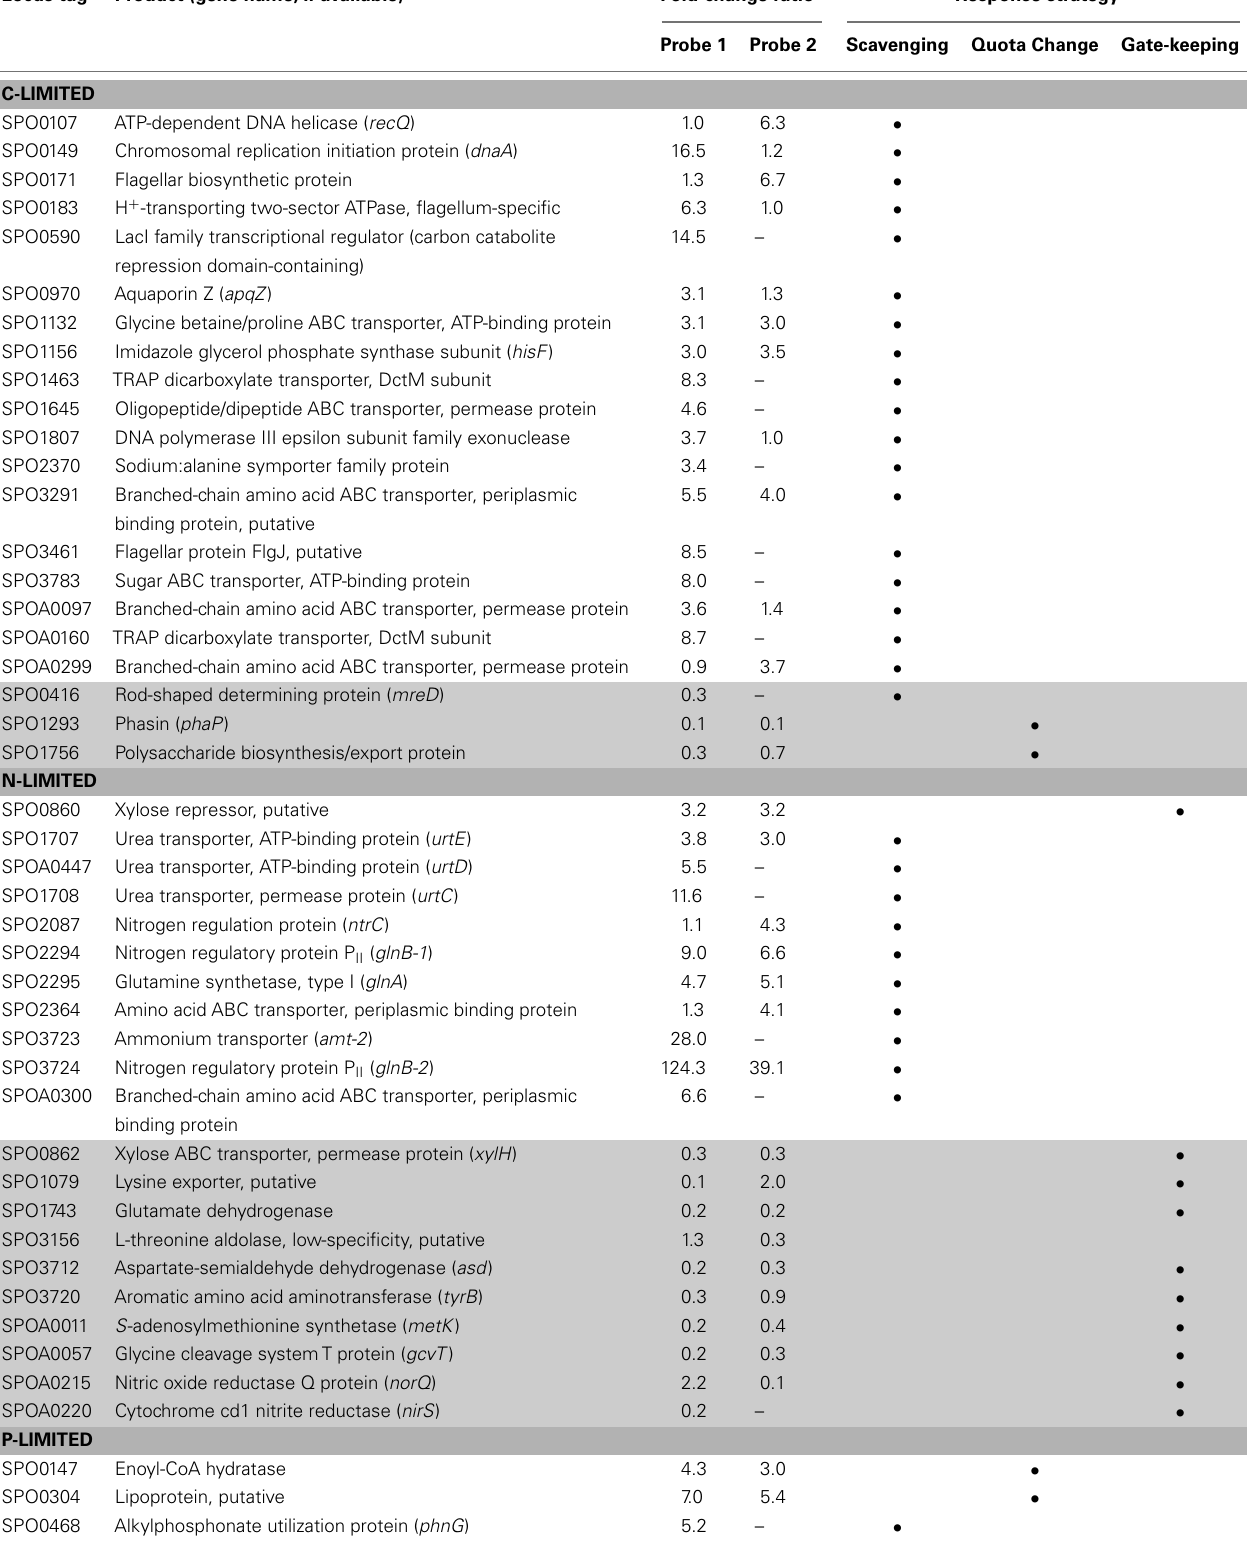
Table 2 | Selected R. pomeroyi DSS-3 genes responding uniquely to a C-, N-, P-, or S-limited regime. Locus